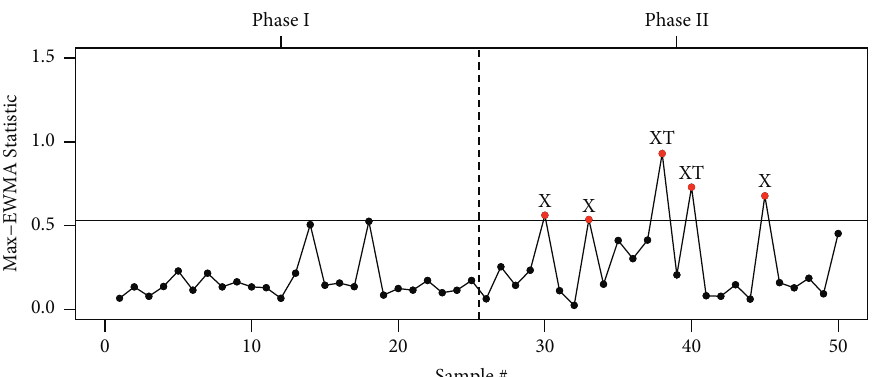
Figure 3: Max-EWMA chart for monitoring the fire outbreaks considering the pure shift in the shape parameter of unit gamma